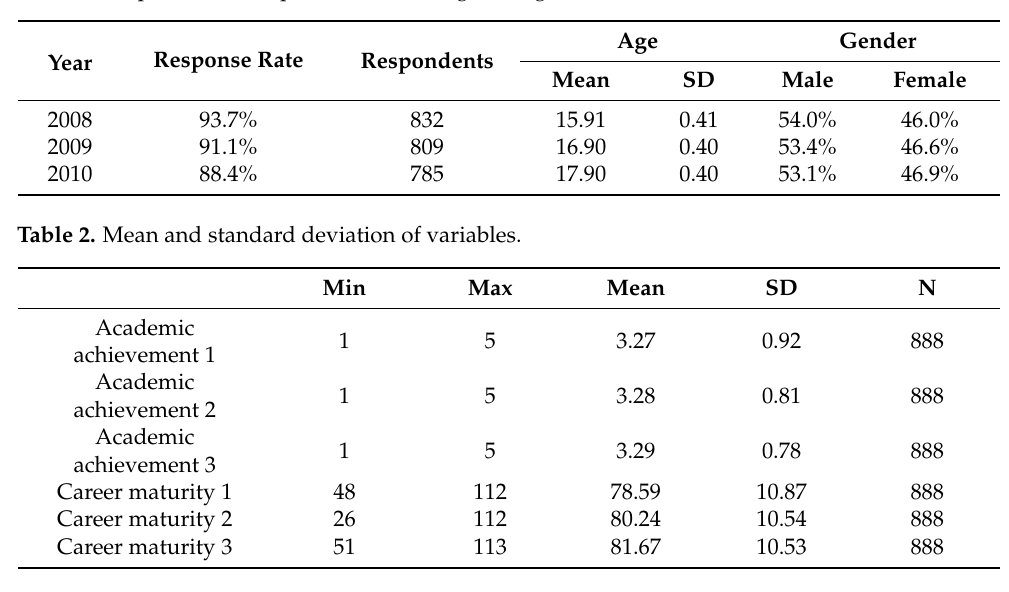
Table 1. Response rate, respondents, mean age, and gender ratio N = 888.